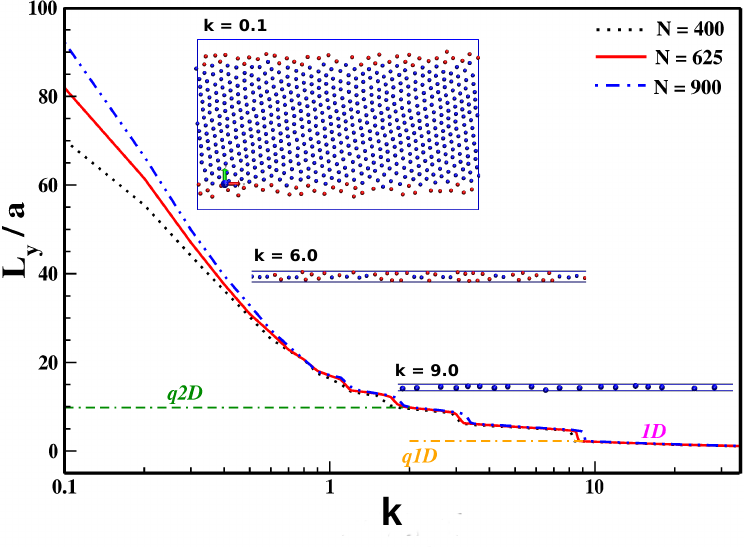
Figure 1. Box length in the y -direction as a function of the trap stiffness k for three different system sizes. Snapshots were created with VMD [36] and represent typical configurations of particles in q 2 D , q 1 D , and 1 D geometries. The confining harmonic potential acts on each particle individually, but boundary particles (at a given instant of time) are colored in red, and those forming the bulk in blue. Dashed lines represent approximate regions in L y and k where the system exhibits a dimensionality